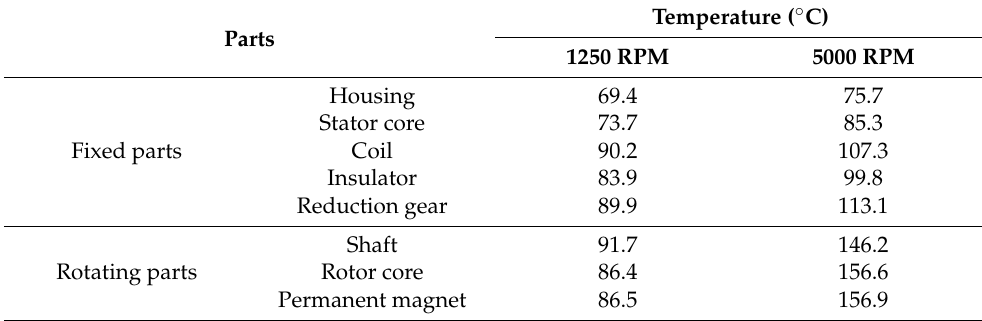
Table 4. Average temperature of each part of in-wheel motor with simple water